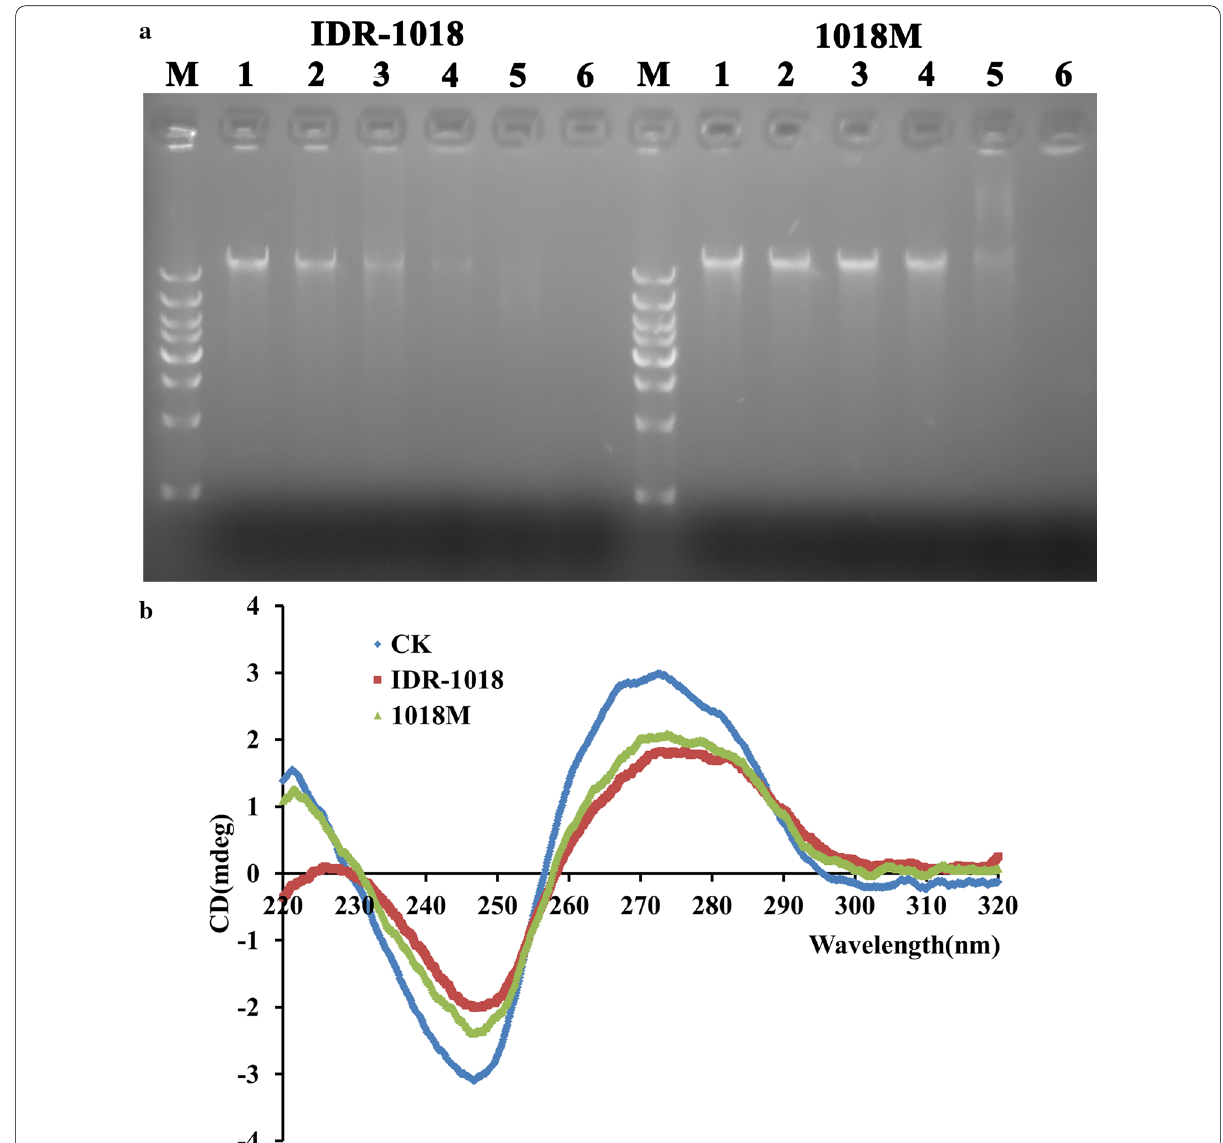
Fig. 4 Interaction of 1018M with MRSA ATCC43300 bacterial genomic DNA. a Interaction of IDR-1018 and 1018M with bacterial genomic DNA by a gel migration assay. M: DNA marker; 1–6: The concentration of peptides were 0, 0.625, 1.25, 2.5, 5, 10 μg/mL, respectively. b CD spectra of genomic DNA from MRSA ATCC43300 in the presence of IDR-1018 and 1018M. The concentration of peptide and DNA were 40 and 150 μg/mL,